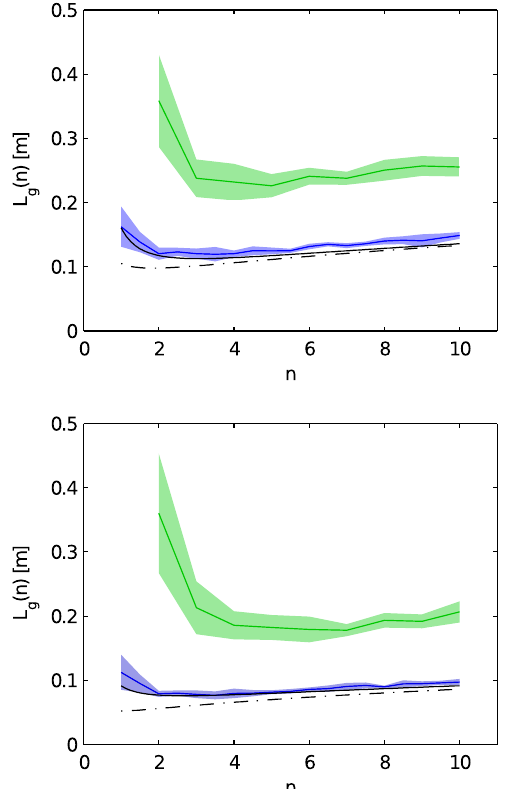
ð n Þ as a function of the stretching factor FIG. 6. Gain length L g n for the short wavelength case (top) and long wavelength case (bottom) obtained from 1D simulation (blue), GENESIS (green), and analytical estimate with bunch length correction (solid black) and without (dash-dotted black). For each data point ten simulation runs with different shot noise seeds were averaged and the shaded areas indicate the standard